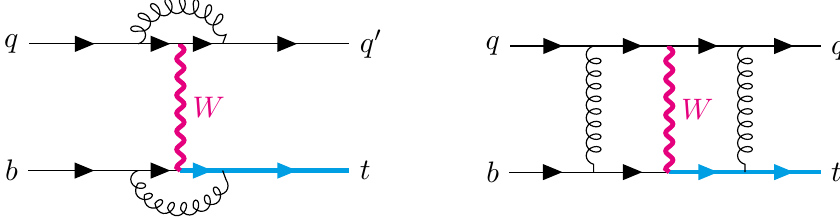
Figure 1. Examples of diagrams contributing to NNLO QCD corrections to single-top production. The diagram on the left is part of the factorisable corrections as the two quark lines interact solely through the exchange of a colourless W boson. On the right, the quark lines are additionally connected by the exchange of two gluons. We classify the latter as a non-factorisable